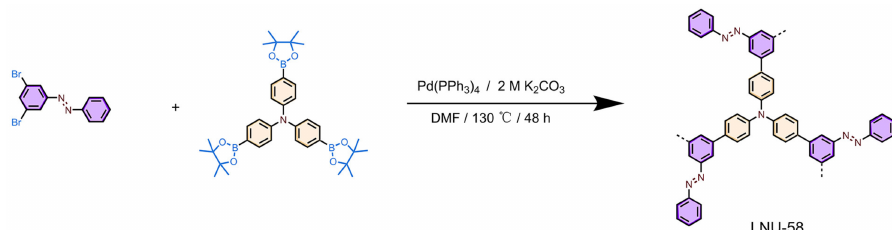
Figure 1. Synthesis and structure of